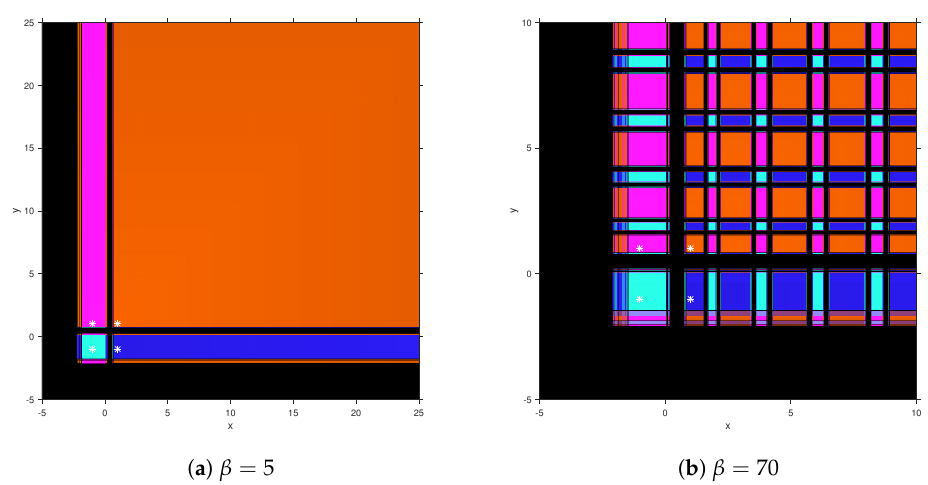
Figure 6. Dynamical planes for stable values of β of class M41 on p ( x ) .